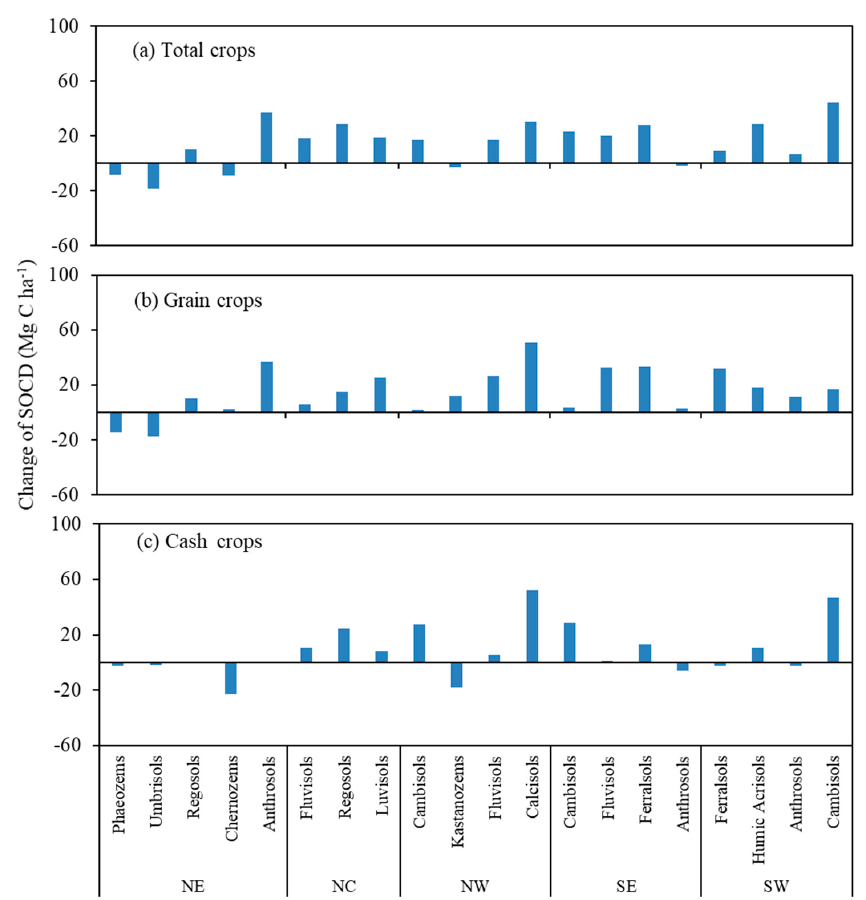
Figure 5. Changes of soil organic carbon density (SOCD) under different soil types for ( a ) total crops, ( b ) grain crops and ( c ) cash crops in China’s croplands between the 1991–2001 and the 2002–2012. NE (Northeast), NC (North Central), NW (Northwest), SE (Southeast) and SW